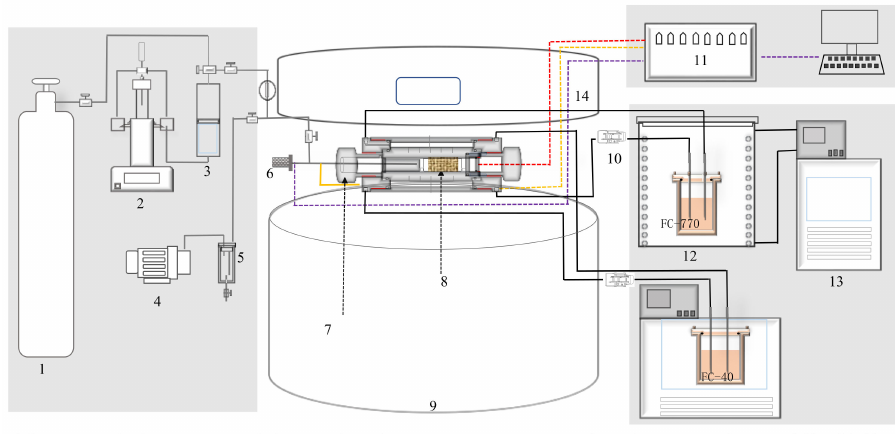
Figure 2. Nuclear magnetic resonance measurement system of natural gas